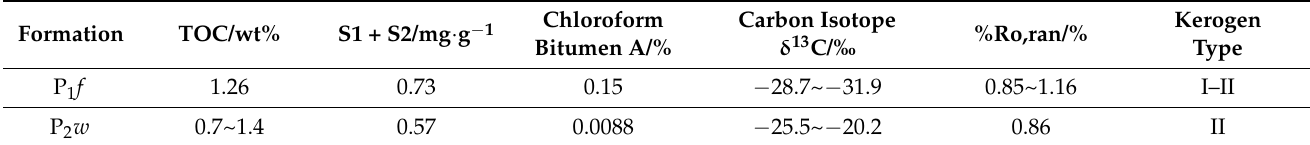
Table 1. Evaluation parameters of main source rocks of Permian in Shawan